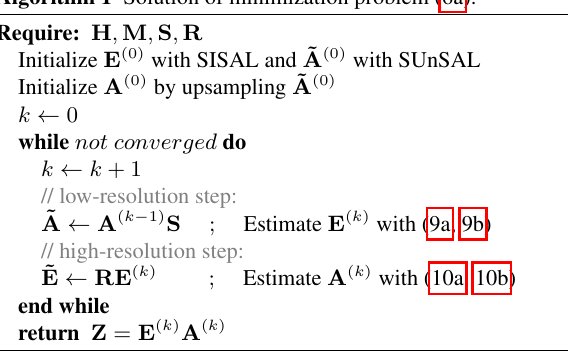
Algorithm 1 Solution of minimization problem